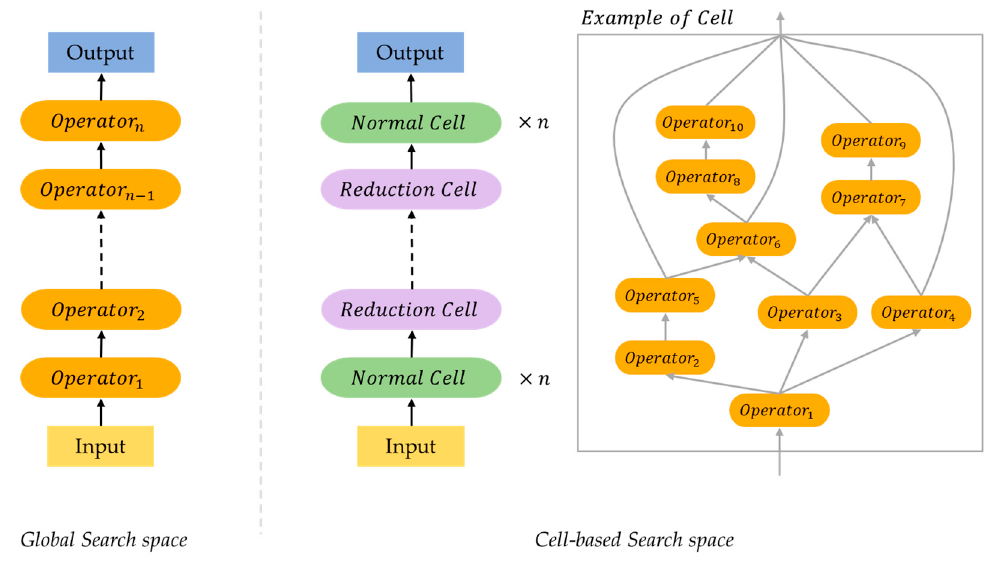
Figure 1. Simplified example of global structured neural architecture and cell structured neural architecture.